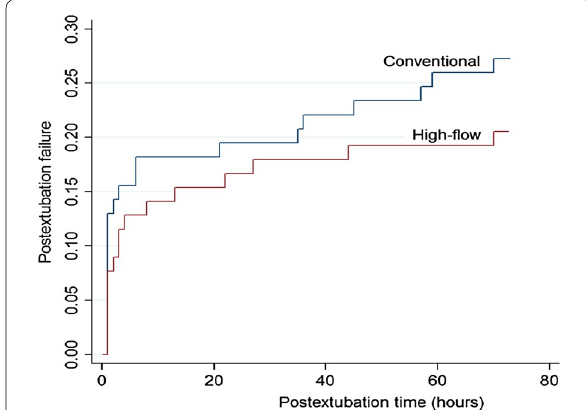
Fig. 2 Kaplan–Meier plot of 72‑h postextubation failure in patients receiving HFNC versus conventional oxygen therapy. The difference did not reach statistical significance ( p =